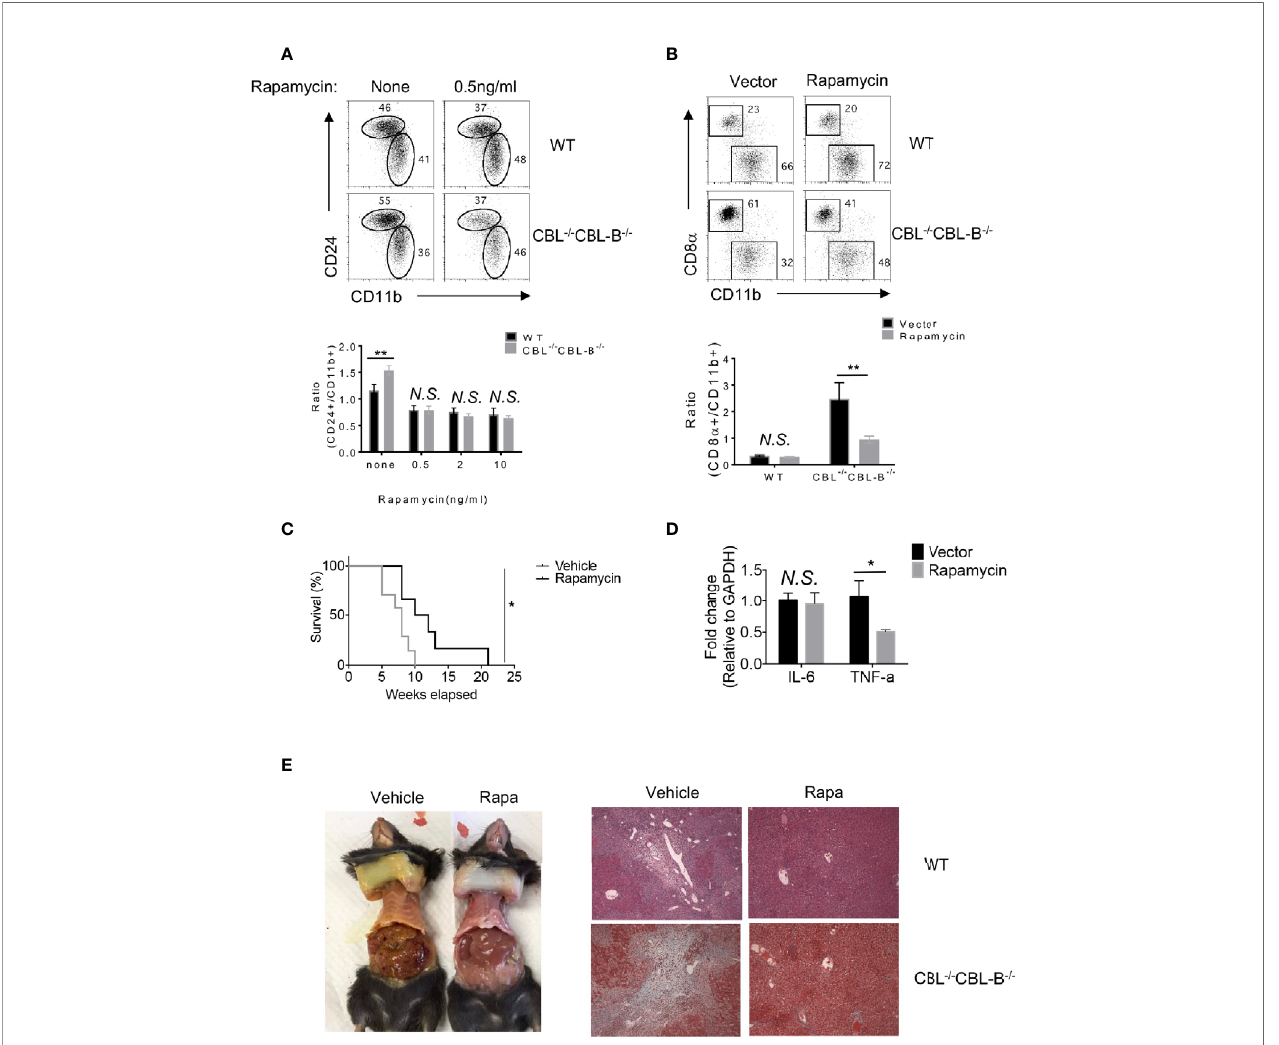
FIGURE 7 | Homeostasis of cDC1s and liver in fl ammation in mTOR treated CBL -/- CBL-B -/- mice. (A) Flow cytometry analysis of CD24 hi CD11b lo and CD24 lo CD11b hi cDCs in FLT3-dependent BM culture treated with rapamycin (n = 3). (B) Flow cytometry analysis of CD8 a + cDC1s and CD11b + cDC2s in WT and CBL -/- CBL-B -/- mice with or without rapamycin treatment (n = 3). (C) Kaplan-Meier survival analysis of CBL -/- CBL-B -/- mice treated with rapamycin or vehicle (n = 6-7). (D) qPCR analysis of liver IL-6 and TNF- a in rapamycin treated CBL -/- CBL-B -/- mice (n = 5). (E) Pathology analysis of CBL -/- CBL-B -/- mice with rapamycin or vehicle treatment. Left: Image of skin jaundice. Right: H-E staining of liver sections. Data are mean ± SEM. of at least two independent experiments (A , B , D , E) . N.S., not signi fi cant; *p < 0.05; **p <